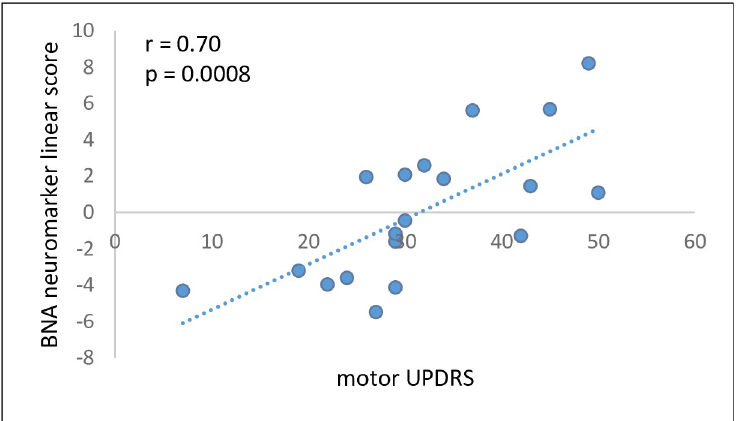
Fig 3. Correlation between the BNA neuromarker linear scores and the mUPDRS scores. Correlation between the BNA neuromarker linear scores and the mUPDRS scores in an independent established PD group (N = 19; one subject was assessed only in the on-state and was not included). mUPDRS, the motor examination (part III) of the Unified Parkinson’s Disease Rating Scale.